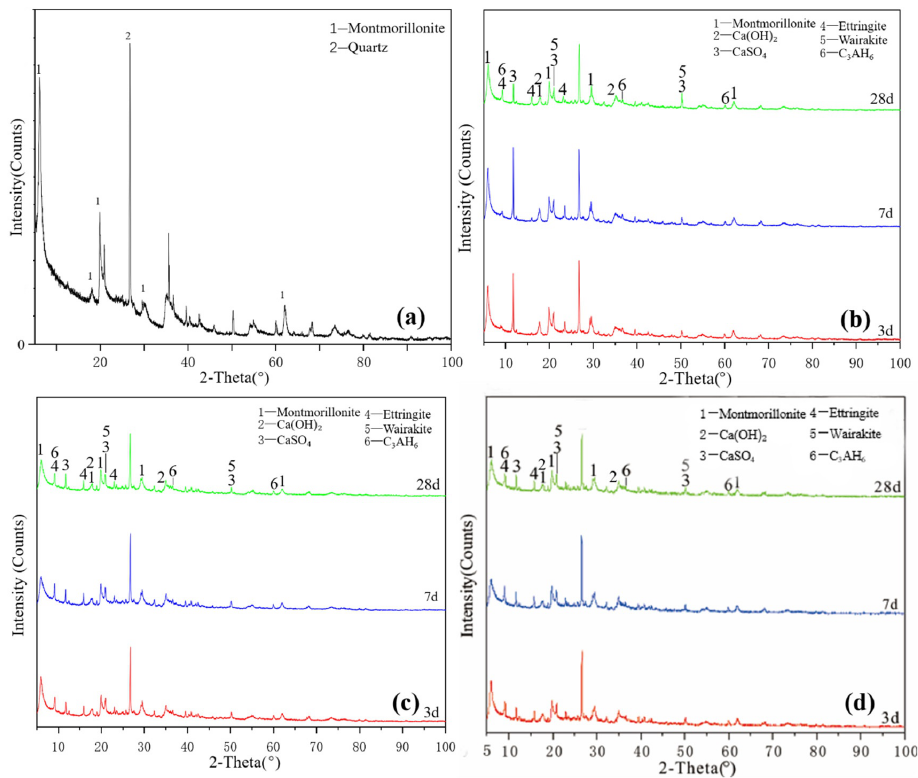
Figure 3. XRD patterns of montmorillonite: ( a ) raw material, ( b ) 3-, 7- and 28-day curing age M0, ( c ) 3-, 7- and 28-day curing age M1, ( d ) 3-, 7- and 28-day curing age M1-2.